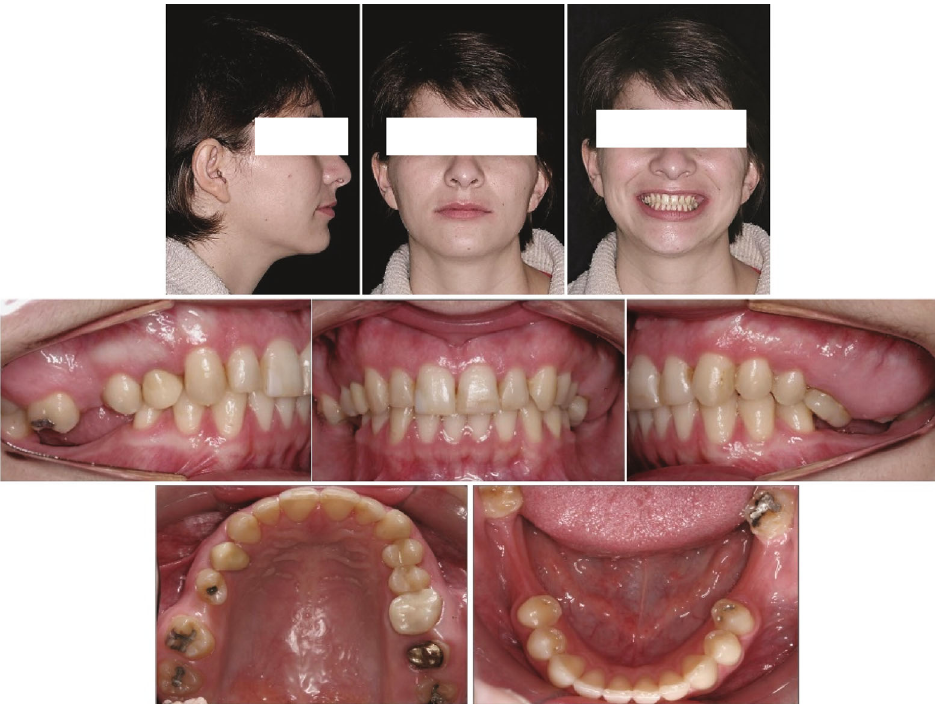
Figure 1: Pretreatment facial and intraoral